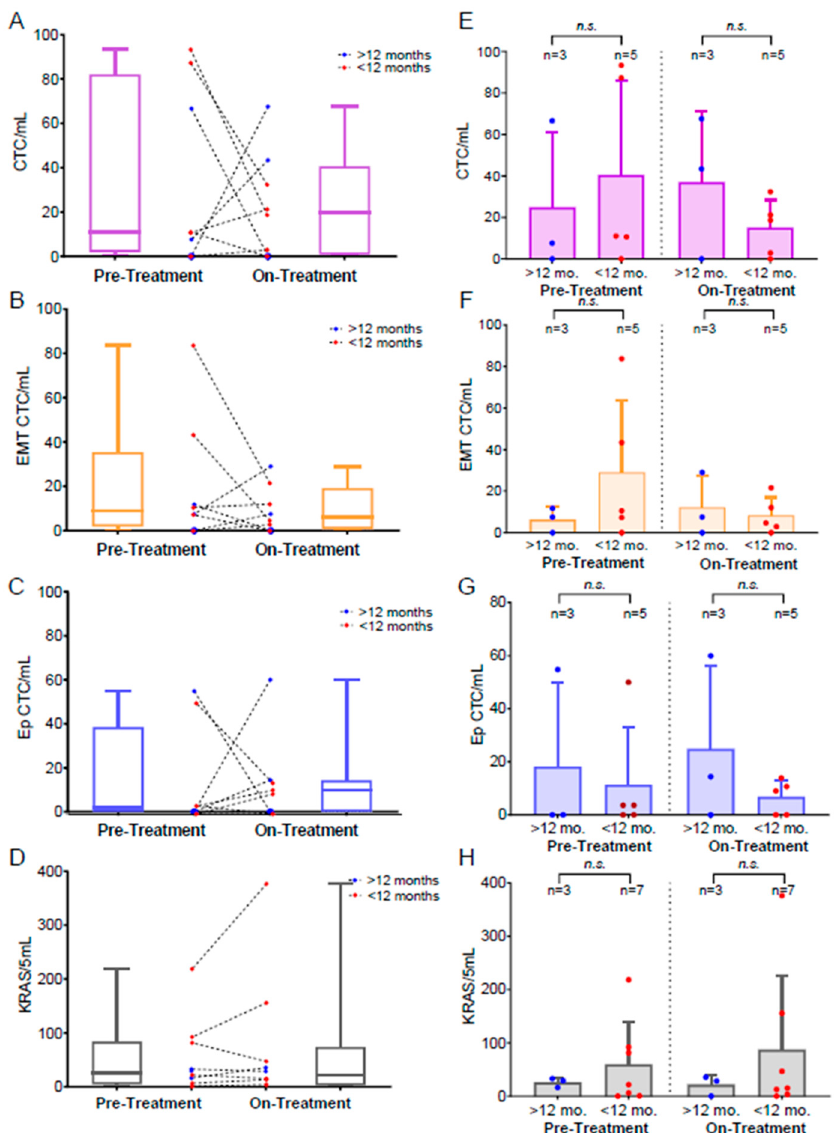
Figure 3. CTC dynamics based on patient survival in matched patients. ( A – D ) Distribution of pre- treatment and on-treatment CTC samples with individual patient trajectories mapped for ( A ) total CTCs ( n = 8 patients), ( B ) EMT-CTCs ( n = 8 patients), ( C ) Ep-CTCs ( n = 8 patients), and ( D ) mutant KRAS expression ( n = 10 patients). Patients with survival of <12 months are shown with red dots and patients with survival of >12 months are shown with blue dots. ( E – H ) Comparison based on patient survival for ( E ) total CTCs, ( F ) EMT CTCs, ( G ) Ep CTCs, and ( H ) mutant KRAS. Error bars represent the standard deviation. n.s. = not significant.